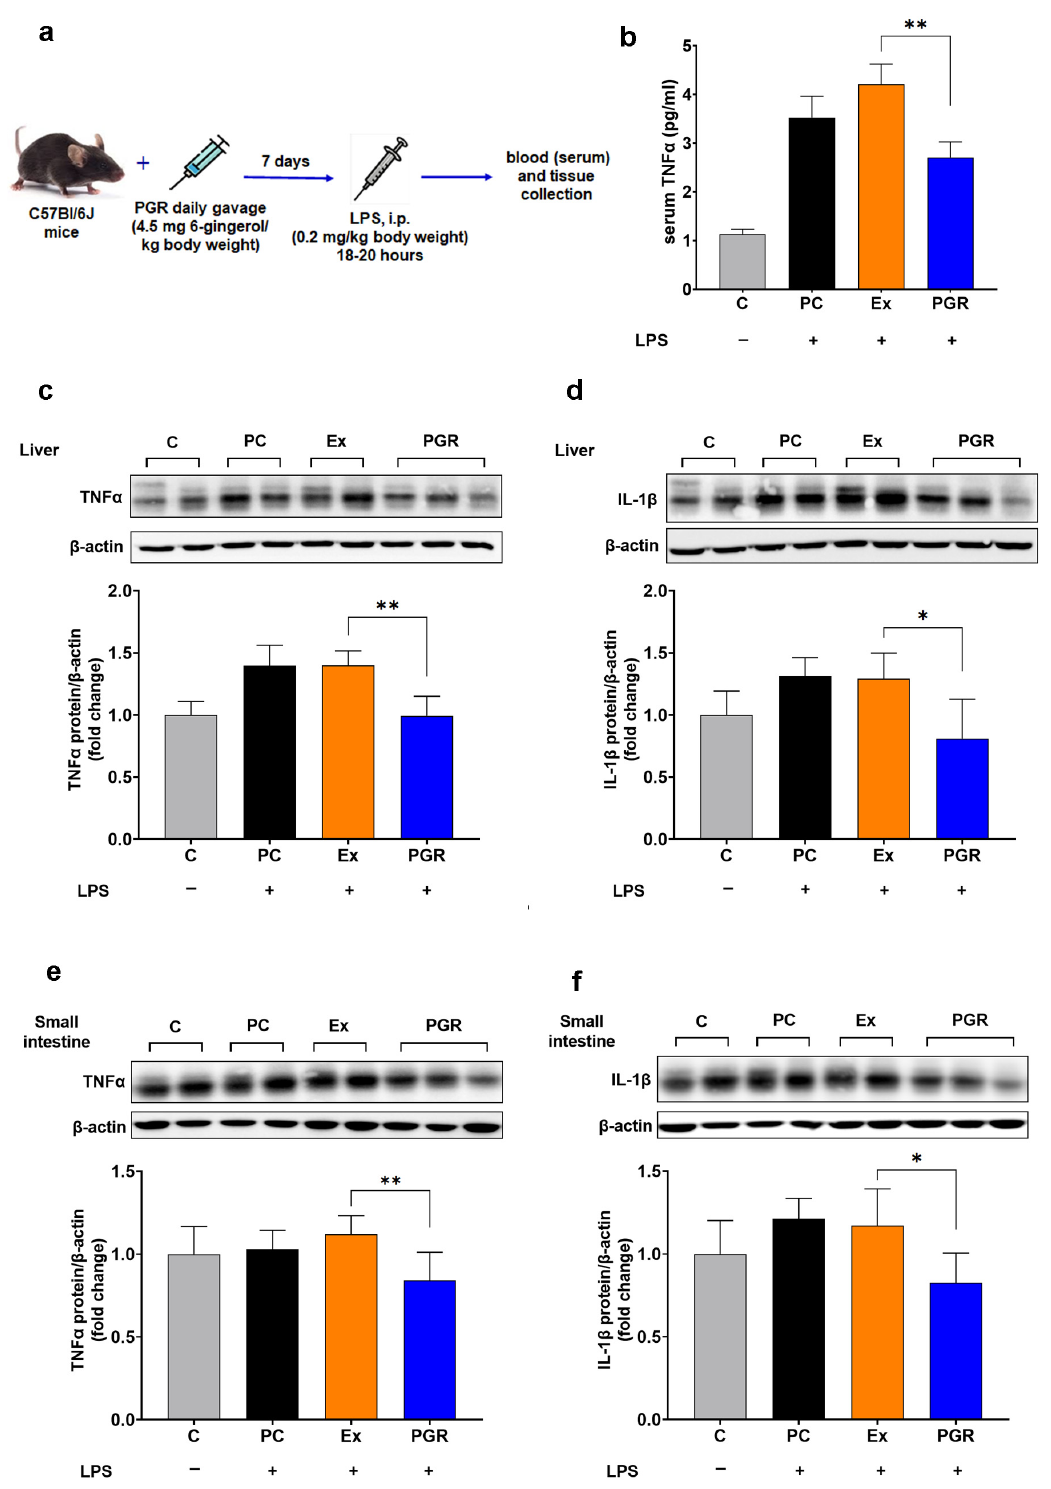
Figure 8. Experimental design for the assessment of the anti-inflammatory effects of PGR 0.5:0.5:1 in vivo ( a ). Levels of tumor necrosis factor α (TNF α ) in sera ( b ) and TNF α and interleukin 1 β (IL-1 β ) in the livers ( c , d ) and small intestines ( e , f ) of mice that received PHYTOGINROSA (PGR), extracts (Ex) and phosphatidylcholine (PC) before LPS-induced systemic inflammation. The results are presented as means ± SD; * p < 0.05, ** p < 0.01 for PGR versus Ex; C—control